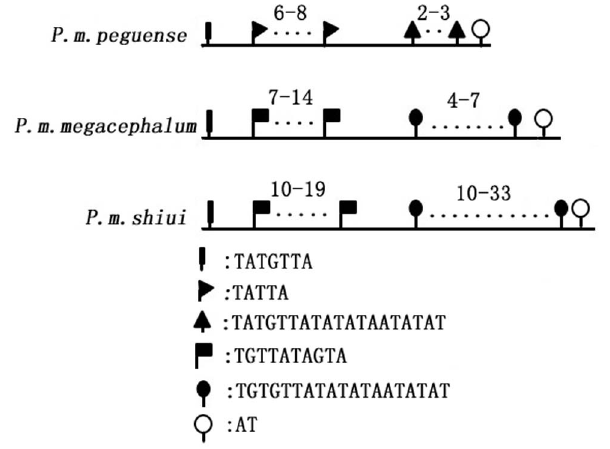
Figure 3. Heterology of VNTRs in different subspecies. The line at the bottom of the image indicates the lengths of VNTRs. The numbers above the dots represent the copy numbers of motifs.